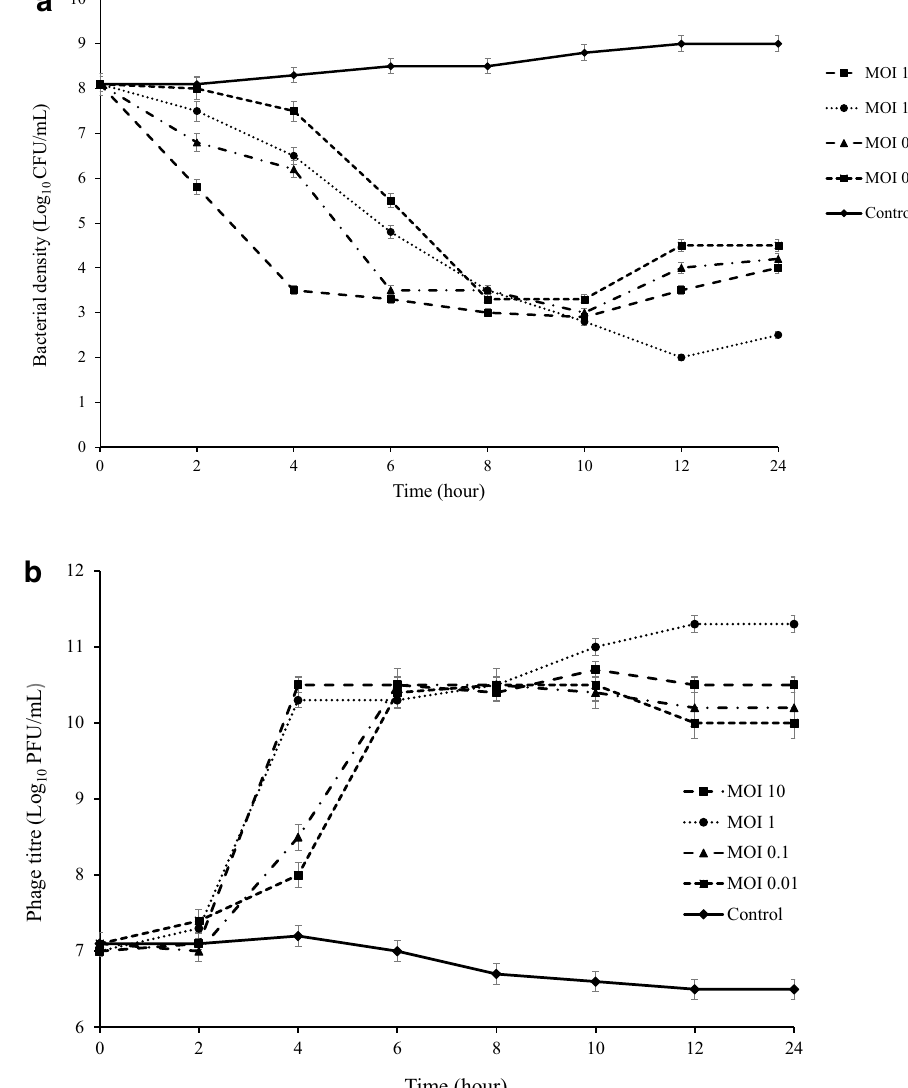
Figure 9. Kinetics of lytic development of the vB_EfaS-SRH2 phage in E. faecalis . ( a ) A number of surviving cells after the phage infection per 1 mL (CFU/mL), and ( b ) a number of phages per 1 mL (PFU/mL). The data represent the average of three independent experiments. Error bars represent the standard